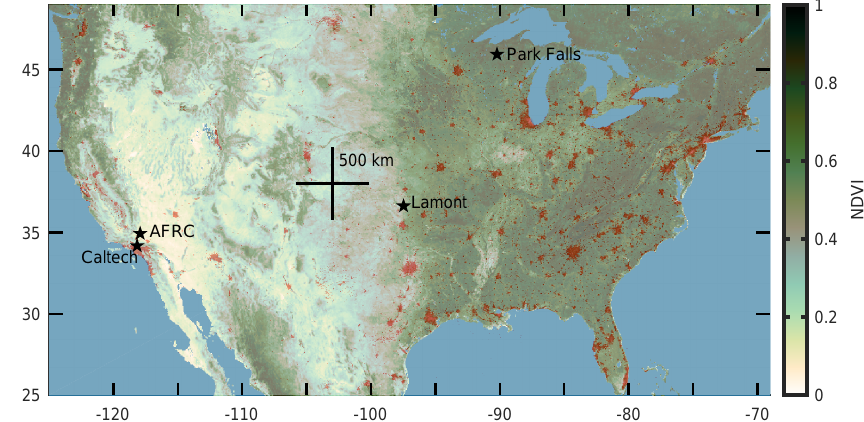
Figure 1. Map of the United States with TCCON sites that were active in 2015 labeled. Normalized difference vegetation index (NDVI) from Terra MODIS (Moderate Resolution Imaging Spectrometer; Didan, 2015) and nightlights from VIIS (Visible Infrared Imaging Radiometer Suite) in red are shown for September 2015. Table 1. Number of measurements prior to any filtering. Site Dates No. No. CIT No. LANL No. Co. ∗ TCCON mFTS mFTS Caltech-1 10 Aug–15 Aug 708 18119 145 AFRC